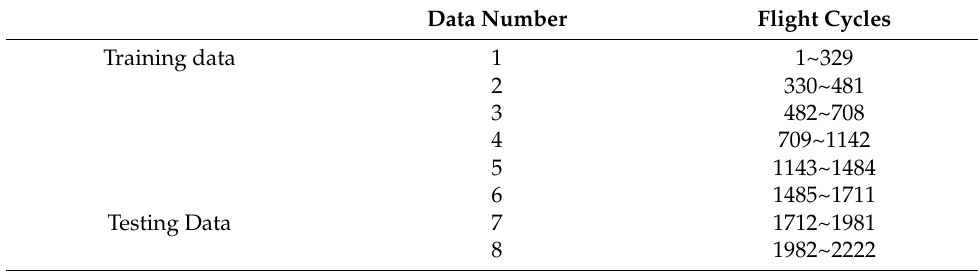
Table 6. Split aeroengine data grouping